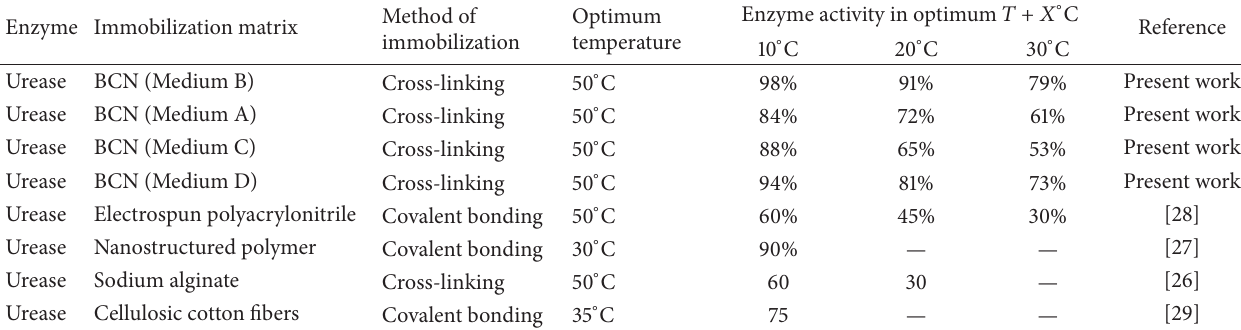
Table 3: Effect of different temperatures on immobilized urease activity.